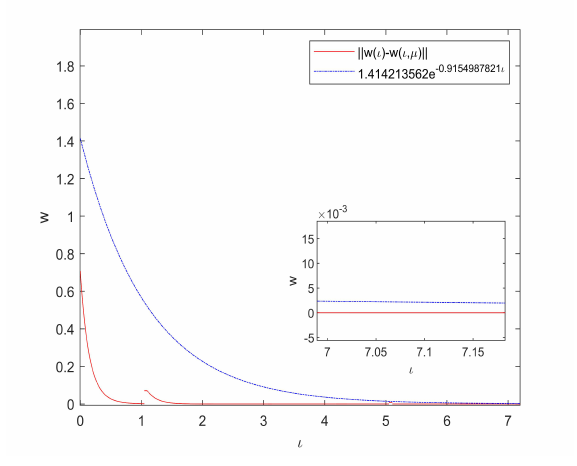
Figure 4. The exponentially stable solution of model